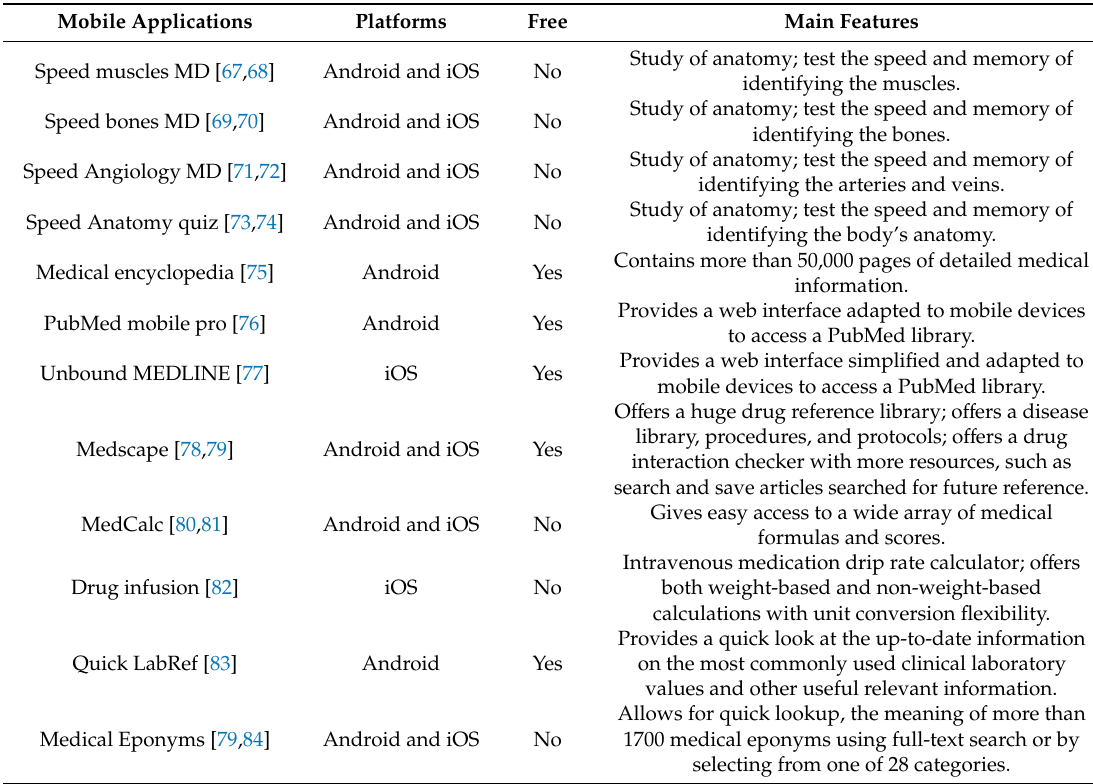
Table 1. Mobile health applications related to literature